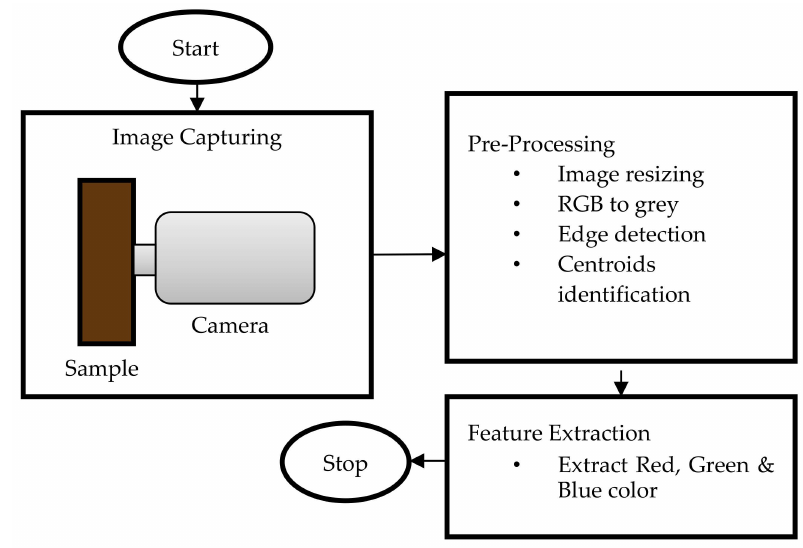
Figure 11. Set-up for palm oil image processing [81].